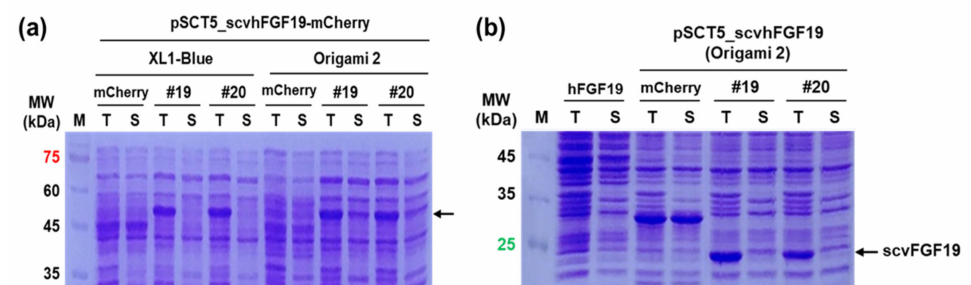
Figure 3. Analyses of the expression of the selected codon variants 19 and 20 in E. coli XL1-Blue and Origami 2. ( a ) Expression patterns of the selected codon variants with mCherry fusion in E. coli XL1-Blue and Origami 2. mCherry: expressed mCherry as a control; 19–20: the selected codon variants with mCherry fusion. ( b ) Expression patterns of the two selected codon variants without the fusion partner mCherry in E. coli Ogriami 2. mCherry: expressed mCherry as a control; hFGF19: expression of wild type hFGF19 without mCherry as a control; 19–20: expression of codon variants 19 and 20 without